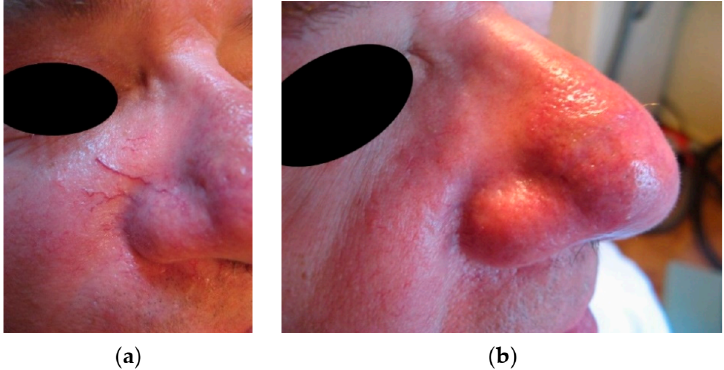
Figure 7. Telangiectasia on the nose: ( a ) before treatment and ( b ) after